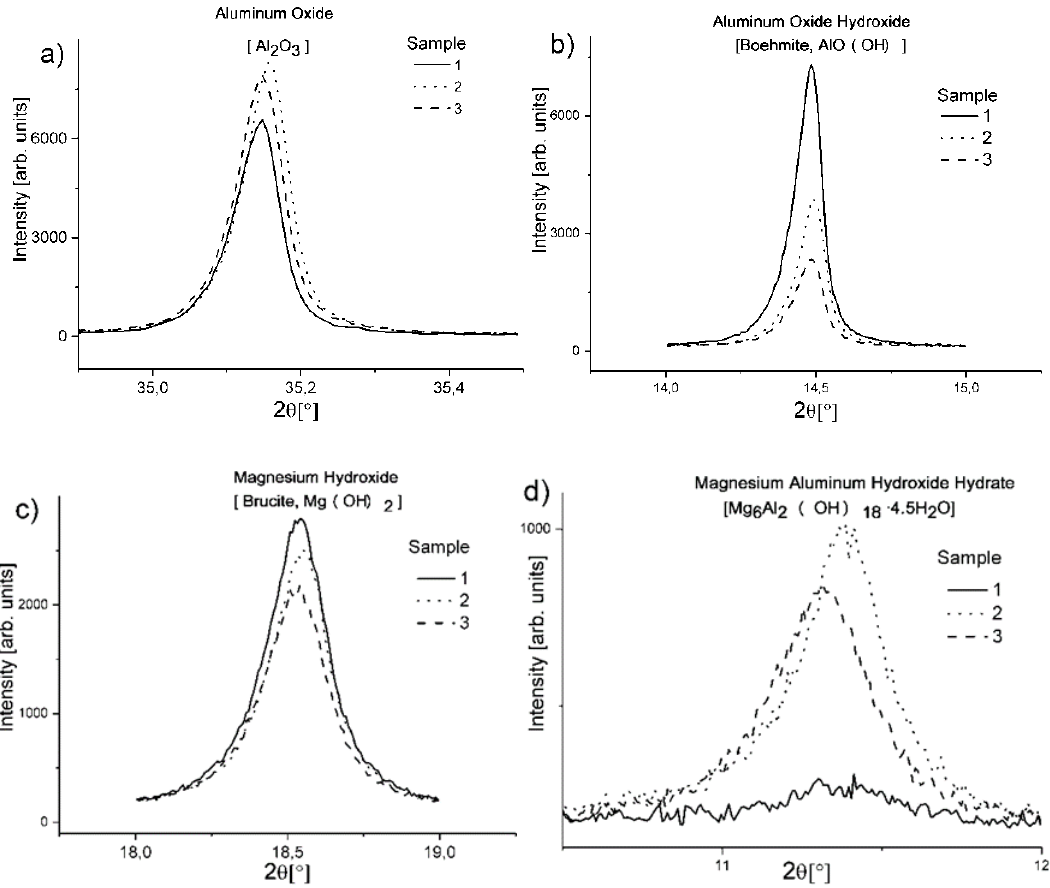
Figure 5. Figure 5. Comparison of the characteristic XRD peaks for a specified phase: ( a ) Al and ( d ) Mg 6 Al 2 (OH) 18 · 4.5H 2